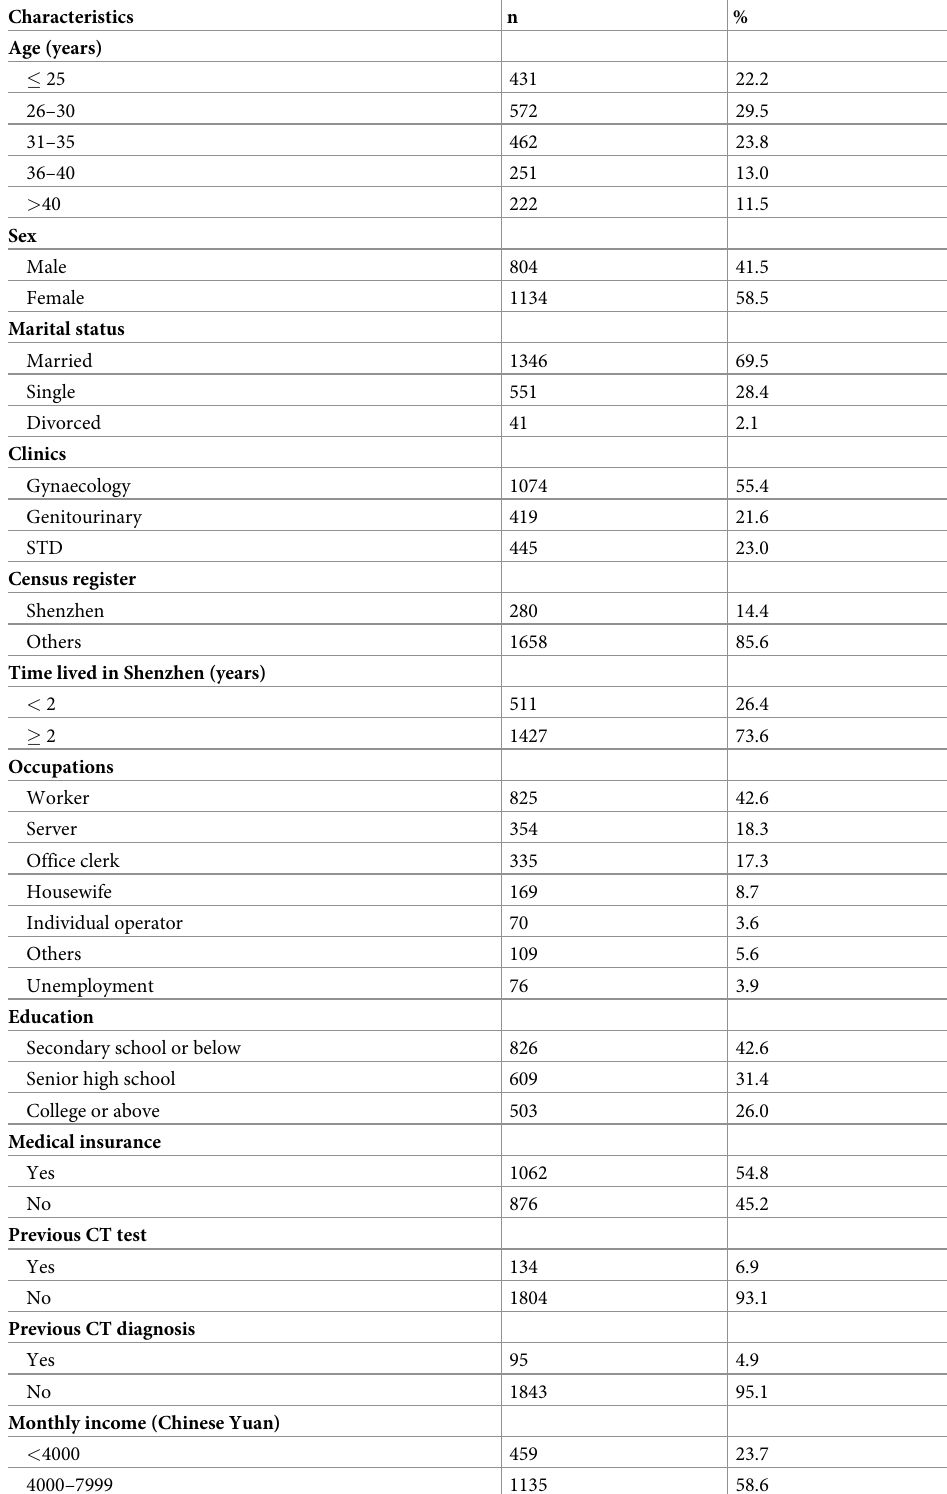
Table 1. Characteristics of